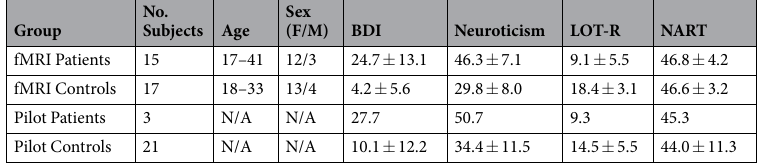
Table 1. Demographics of participants from both dataset versions (see Table S1 for more details). BDI, Beck Depression Inventory; LOTR, Life Orientation Test – Revised; NART, National Adult Reading Test; Data given as n or mean ± std. Due to the small number of Pilot patients, standard deviations are not shown for this